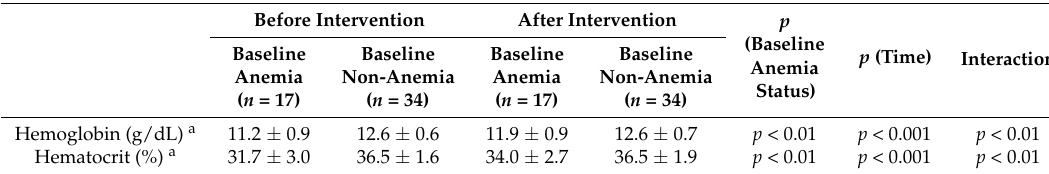
Table 4. Hemoglobin and hematocrit levels divided into two groups at baseline, before and after the intervention.